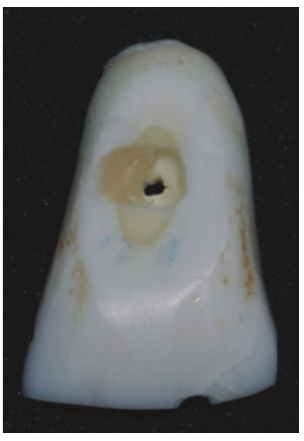
Figure 3: Illustration of mixed failure